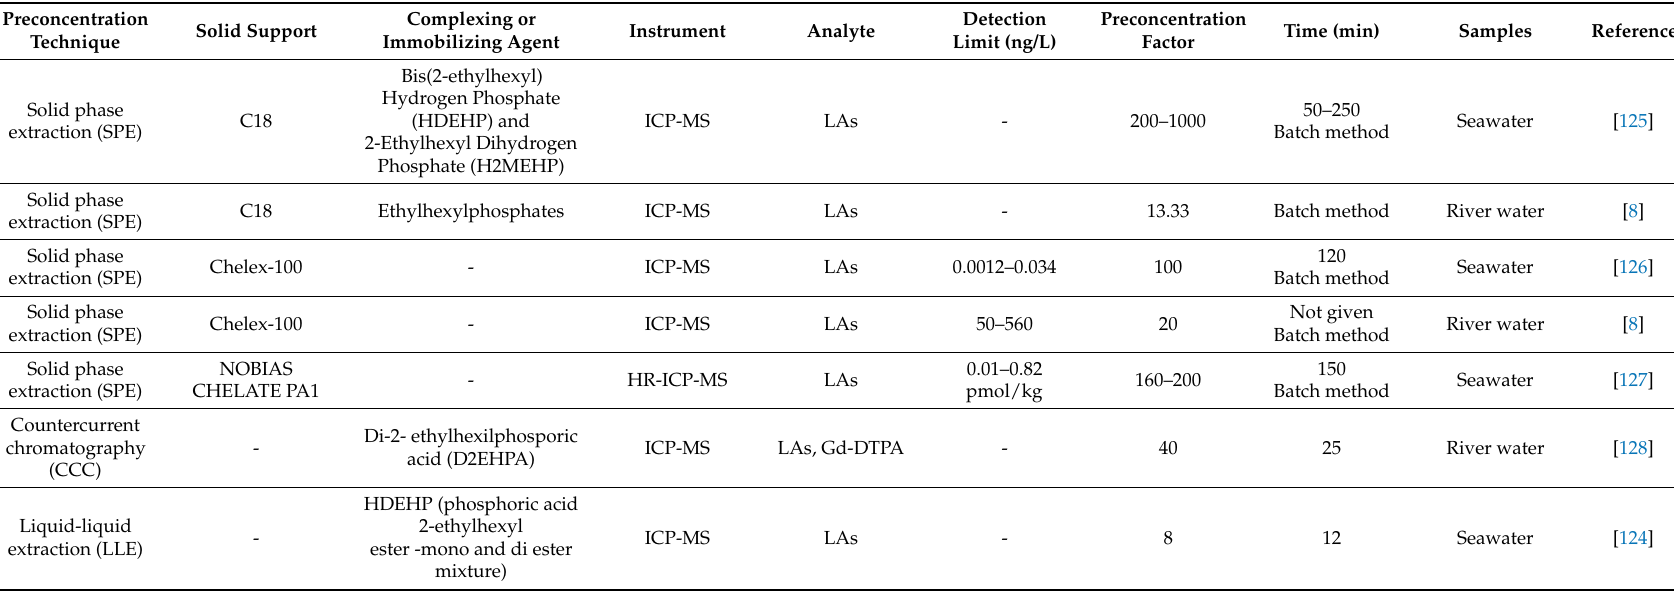
Table 4. Different preconcentration procedures utilized for the separation of the complete set of LAs, including Gd anth